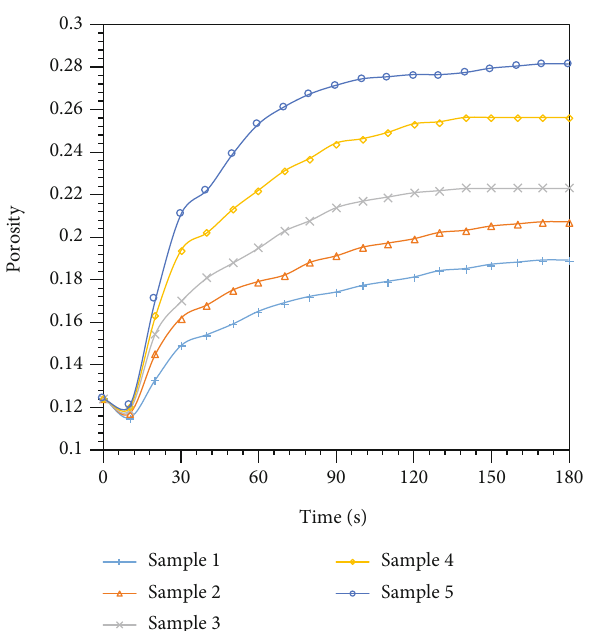
Figure 8: Evolution of water pressure at outlet during the erosion seepage.